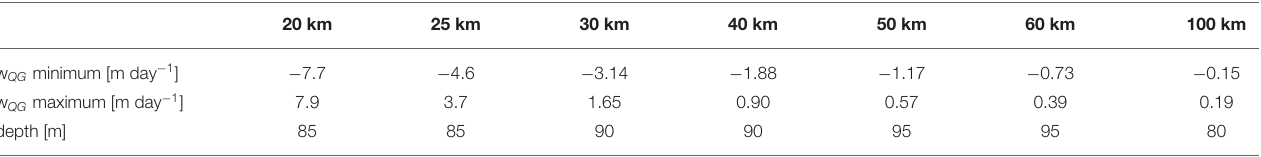
TABLE 3 | Sensitivity test of w QG to the correlation scales used in the optimal interpolation of the original density field. 20 km